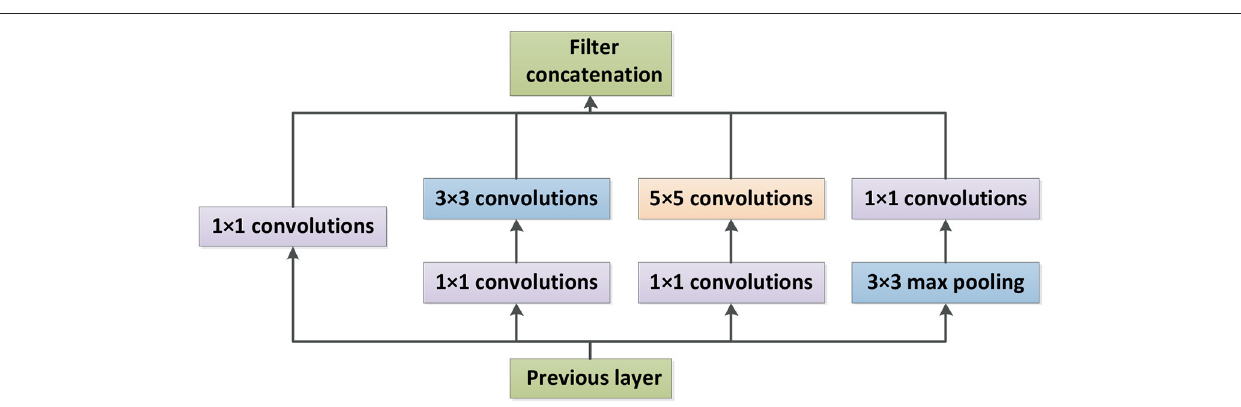
is a combination structure of batch normalization (BN), rectified linear units (RELU), and convolution (Conv), named BN-ReLU- Conv (1 × 1)-BN-ReLU-Conv (3 ×